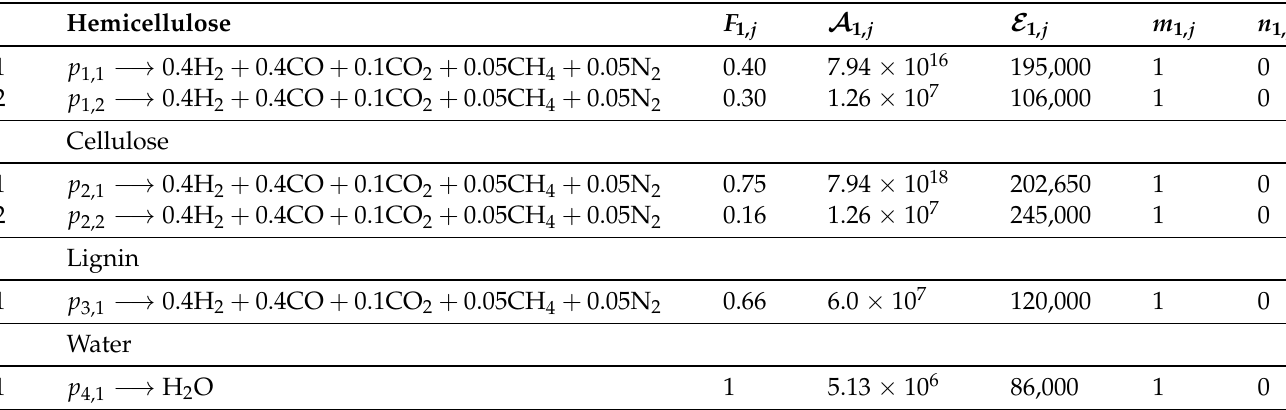
Table 2. Pyrolysis reactions and kinetic parameters. The four species (hemicellulose, cellulose, lignin, and water) undergo different degradation processes according to the chemical reactions listed in this table.